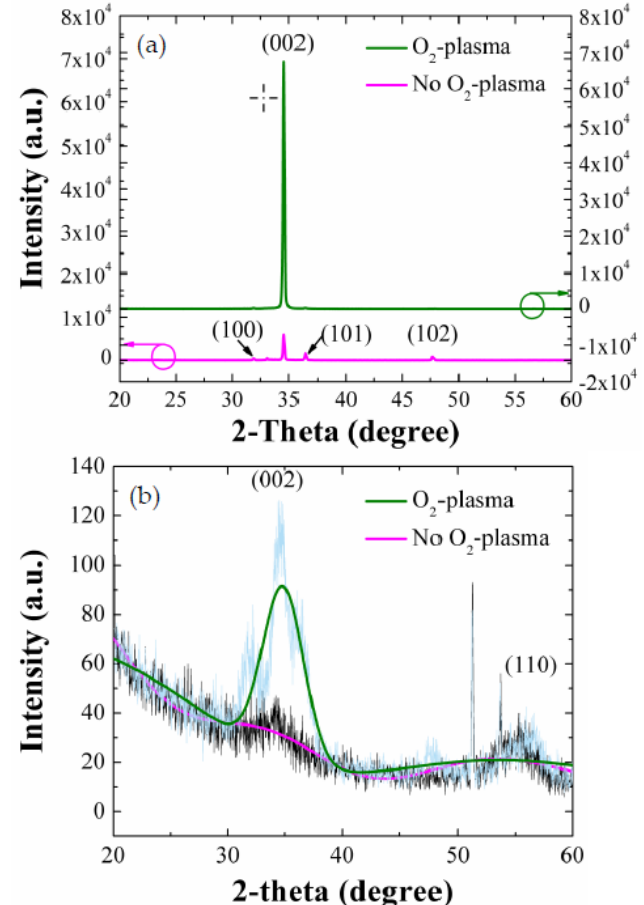
Figure 4. θ –2 θ scan XRD patterns for ( a ) ZnO NRs (grown on SLs as-coated and O 2 -plasma-treated for 9 min) and ( b ) SLs (as-coated and O 2 -plasma-treated for 9 min). As shown from earlier research [22], the ZnO NRs tend to evolve from (002) growth mode of the lowest surface free energy (1.6 J/m 2 ) to other crystal plane growth modes such as (100) and (102) (3.4 and 2.0 J/m 2 ) when the growth proceeds under a higher energy state, therefore the ZnO film growth can be activated from relative lower surface free energy mode to higher energy mode. As shown in Figure 4b, the plasma-treated SL crystals have a more highly preferred orientation toward (002) than the as-coated SLs. This explains one of the reasons why we have a strong c-axis alignment along the vertical direction to the substrate when the ZnO NRs are grown on the plasma-treated SLs, because each crystalline surface of the SL grain oriented toward a specific direction acts as a nucleus for the growth of crystalline NRs. The degree of ( hkl ) orientation is given by the following relationship [12,23]